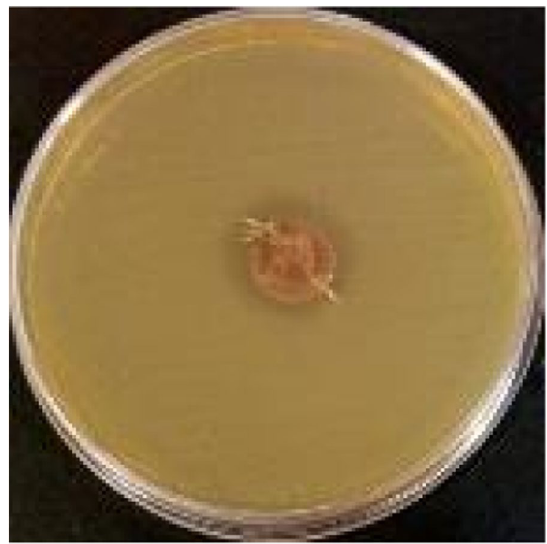
Fig. 9 Antimicrobial activity of